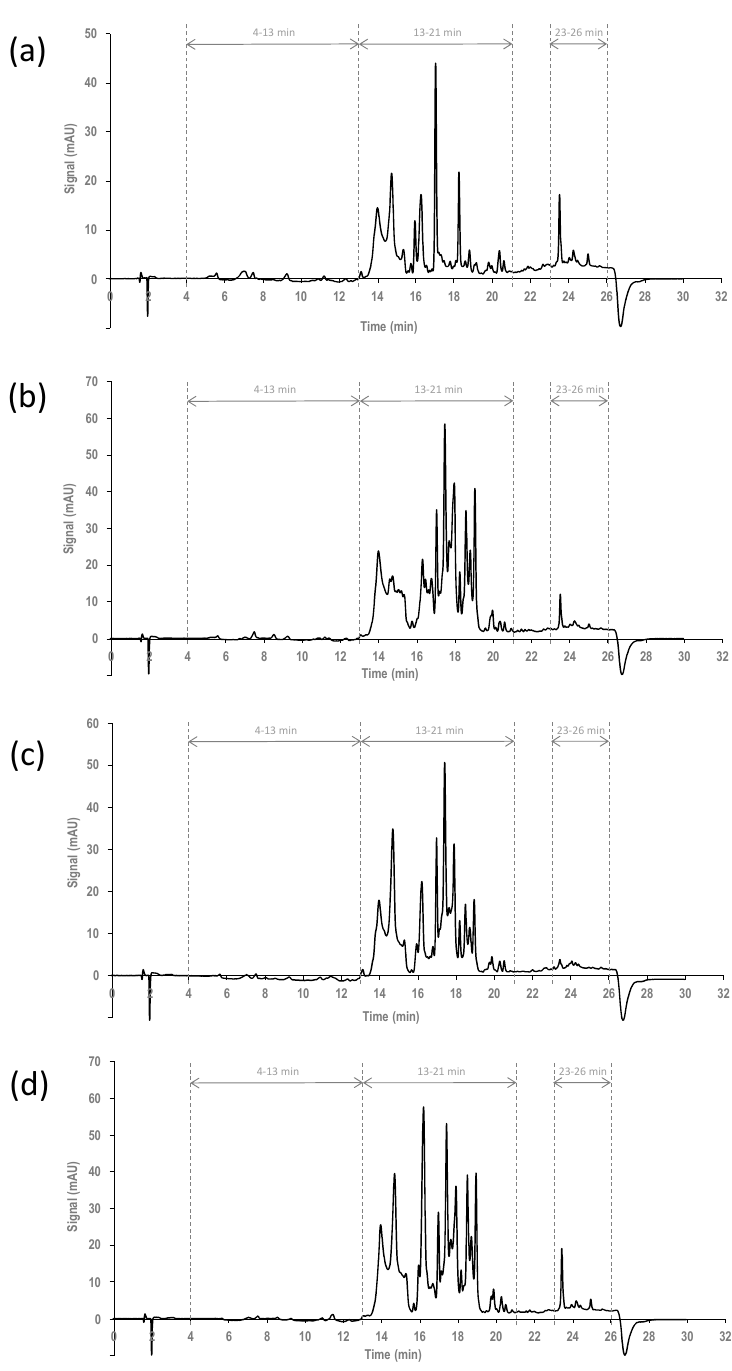
Figure 2. HPLC-UV chromatographic fingerprint registered at 257 nm for four extra-virgin olive oil (EVOOs) obtained from ( a ) Arbequina; ( b ) Picual; ( c ) Hojiblanca; and ( d ) Cornicabra monovarietal olive cultivars.